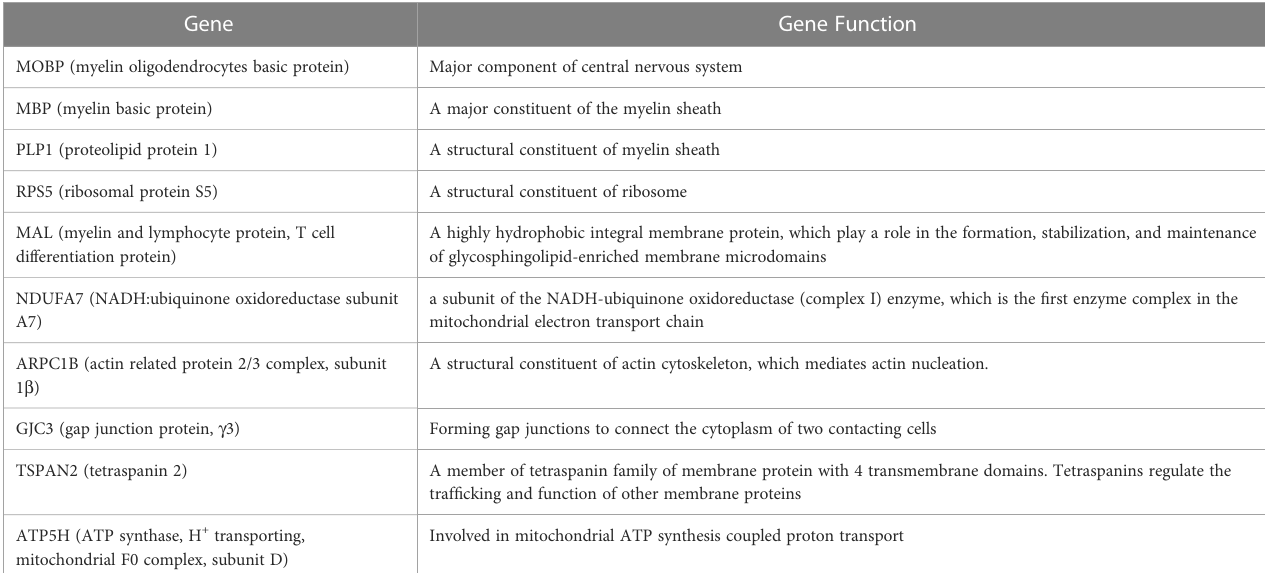
TABLE 1 Genes associated with upregulation of signaling pathways and their functions in brain and spinal cord of demyelinated mice. Gene Gene Function MOBP (myelin oligodendrocytes basic